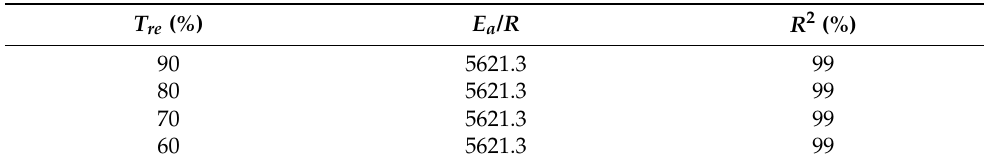
Table 7. Values of E a / R (G2) based on the second prediction model.